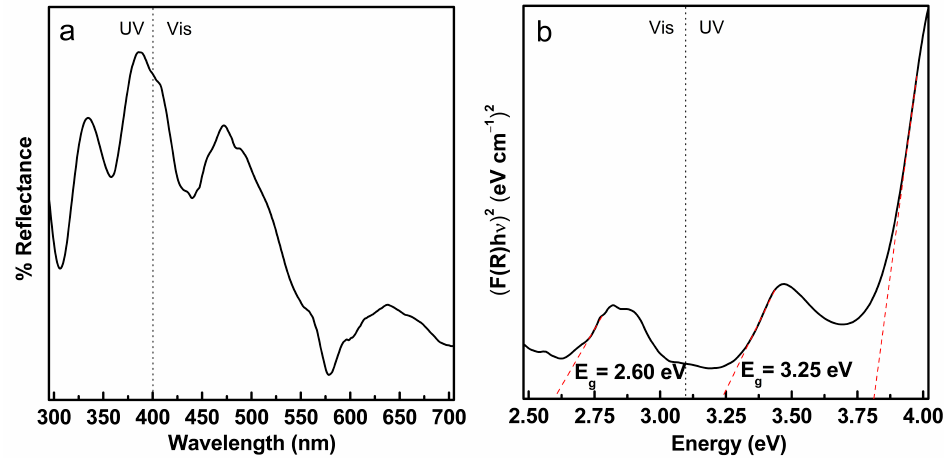
Figure 7. UV/Vis-DRS of Fe/TiO 2 –cMDF ( a ) Diffuse reflectance spectrum ( b ) Kubelka–Munk